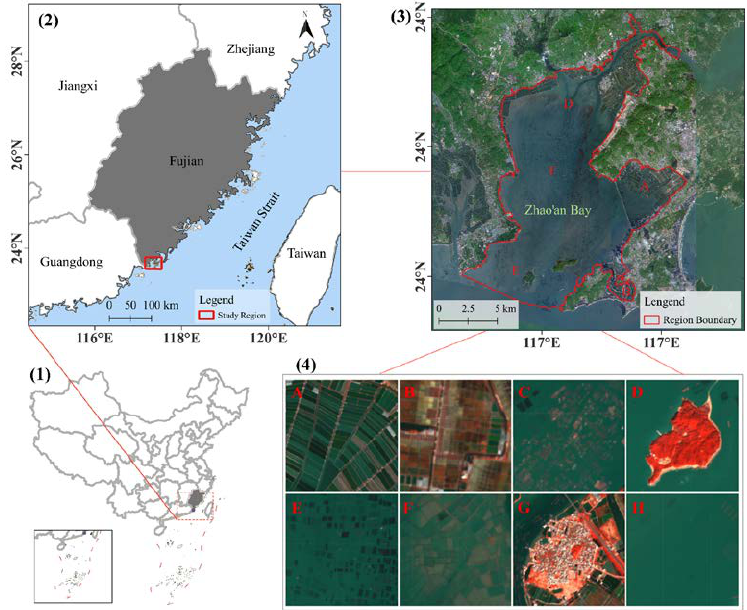
Figure 1. Maps showing the location of the study area and images of different mariculture types. ( 1 – 3 ) Location of study area at different scale; ( 4 ) Satellite image of different types of land cover. A: pond; B: salt pan; C: cage; D: vegetation cover; E: raft; F: mudflat; G: built-up land; H: seawater.